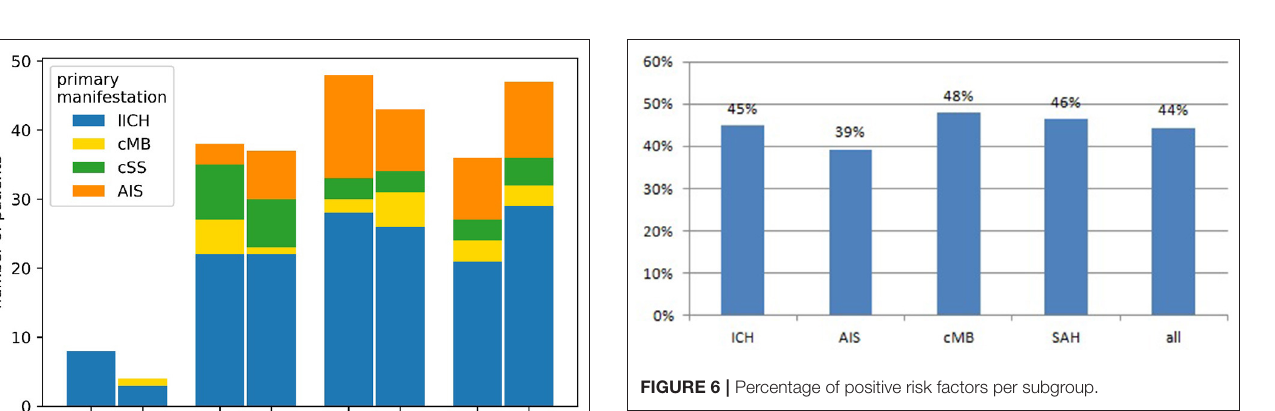
most likely is explained by age; and more prevalent diabetes